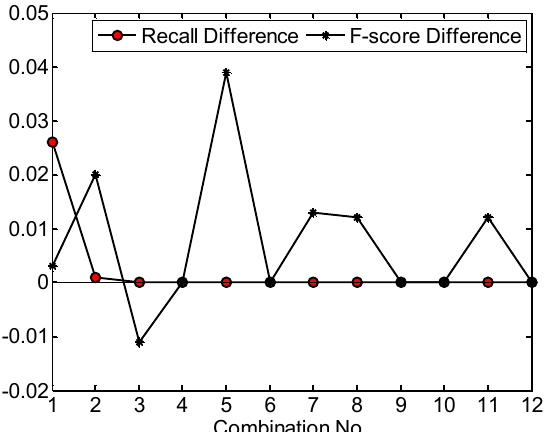
Figure 15. The effects caused by changing significance level on test site 2. Recall (F-score) differ- ence is the product of the recall (F-score) generated by using a significance level of 0.05 minus the one generated by using a significance level of 0.10. The parameter values for each combination can be found in Table 3. MaxD = 1.5 m, and score threshold = 9. found in Table 3. MaxD = 1.5 m, and score threshold =